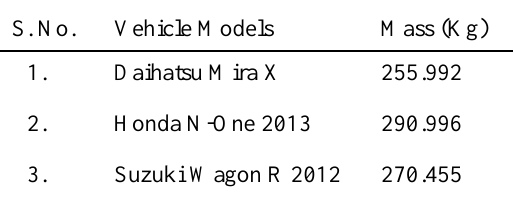
Mass of each vehicle S. No.